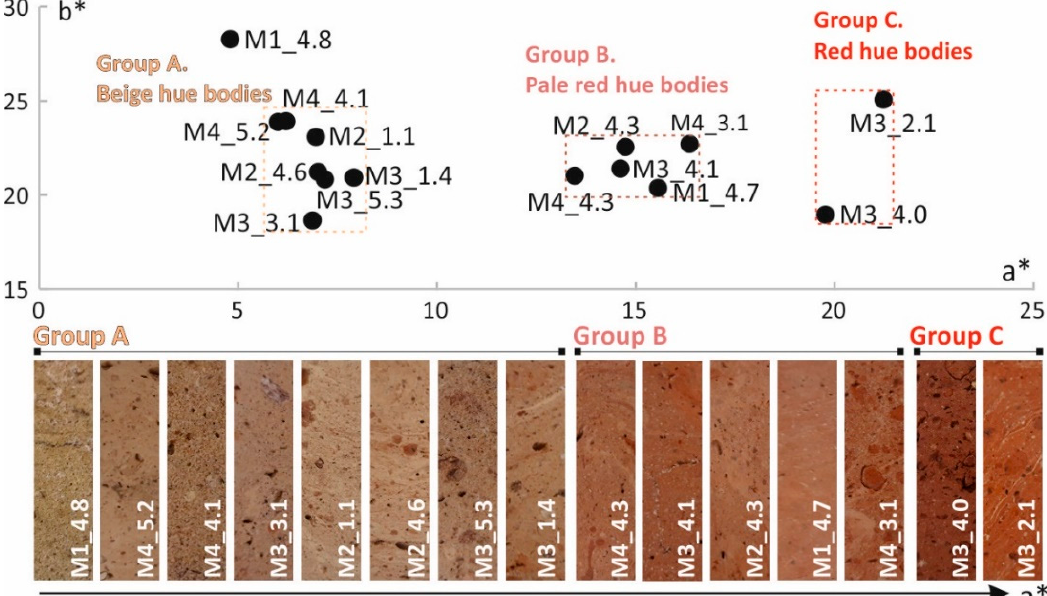
Figure 4. Ceramic bodies hue from the plotting of the chromatic coordinates (a* and b*) and changing colors with increasing of the red